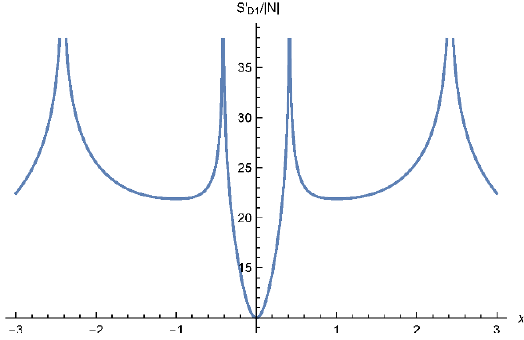
Figure 6 . The function S 0 = j N j , evaluated on the boundary of (cid:6) for the symmetric four external D 1 brane background of (3.8). Note that S 0 = j N j is independent of N by the scaling relations of D 1